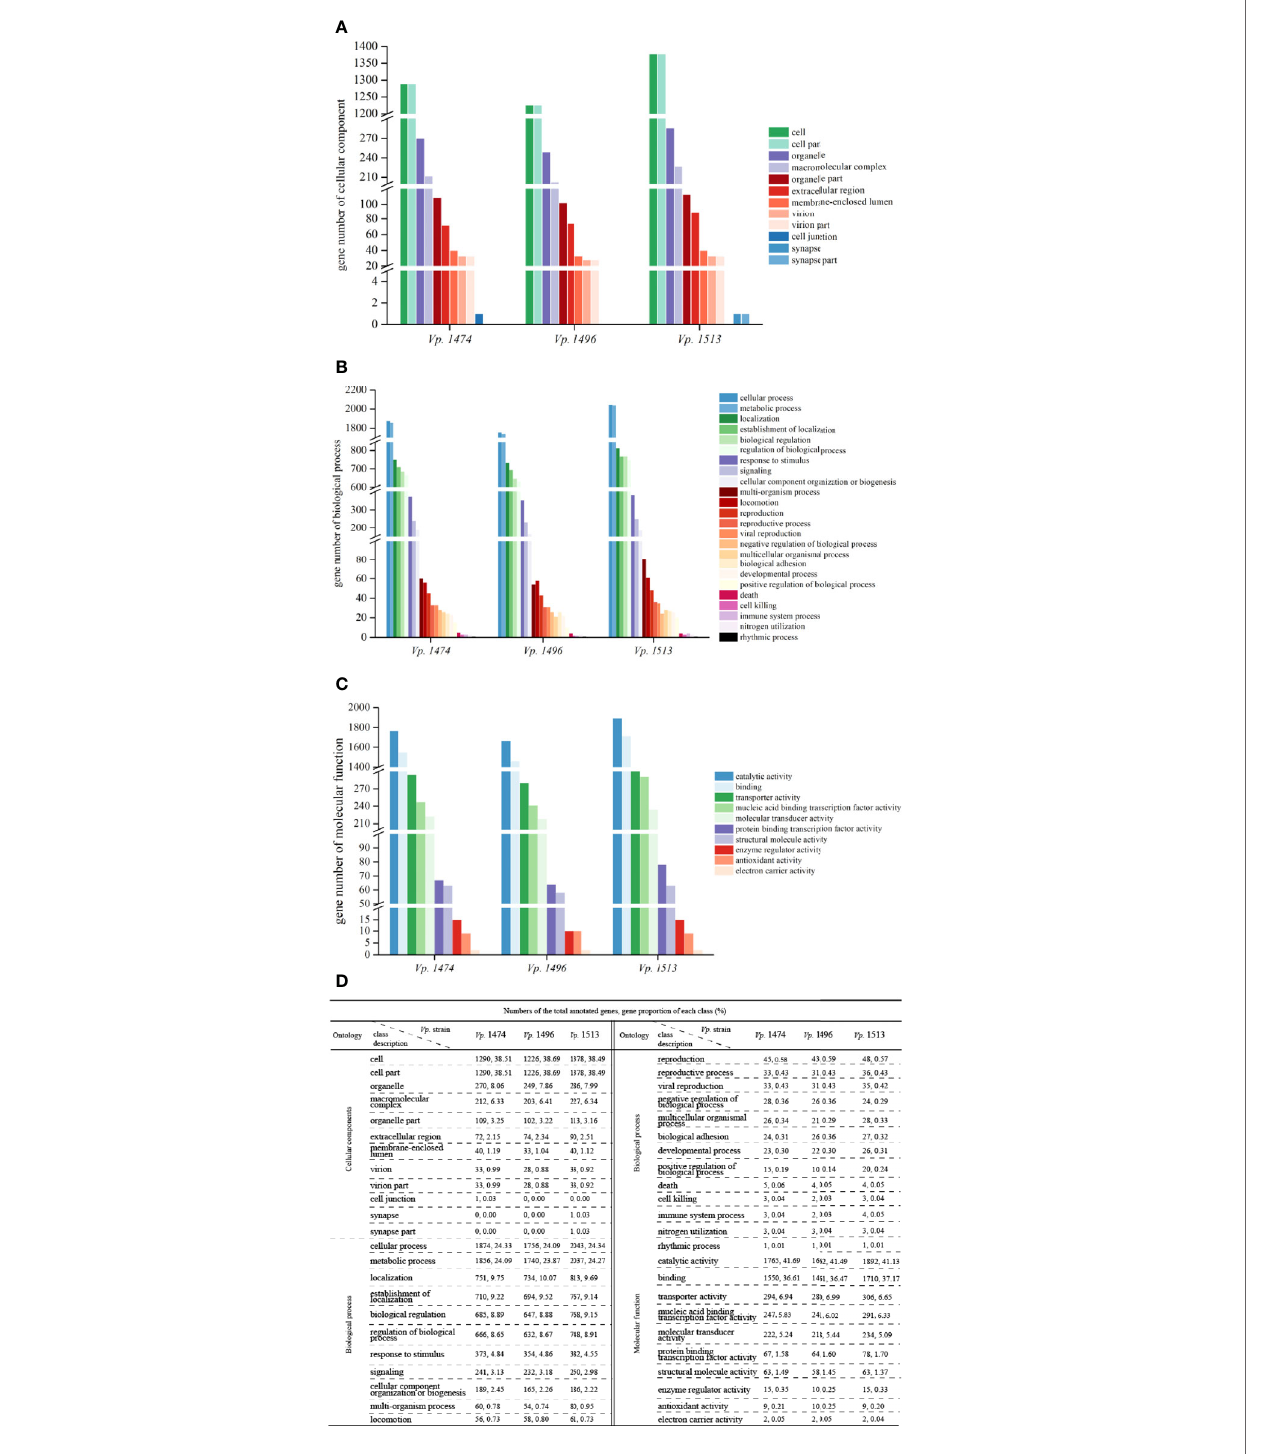
FIGURE 3 | Gene ontology (GO) annotation of V. parahaemolyticus strains Vp . 1474, Vp . 1496, and Vp . 1513. (A) Statistical histogram of gene annotation to cellular component class of the three strains. A total of 13 parts were predicted in the genome of the three strains. Gene numbers are shown on the Y-axis. (B) Statistical histogram of gene annotation to biological process class of the three strains. A total of 24 parts were predicted within genome genes of the three strains. Gene numbers are shown on the Y-axis. (C) Statistical histogram of gene annotation to molecular function class of the three strains. A total of 10 parts were predicted within genome genes of the three strains. Gene numbers are shown on the Y-axis. (D) Statistical data of annotated genes based on GO ontology for the three